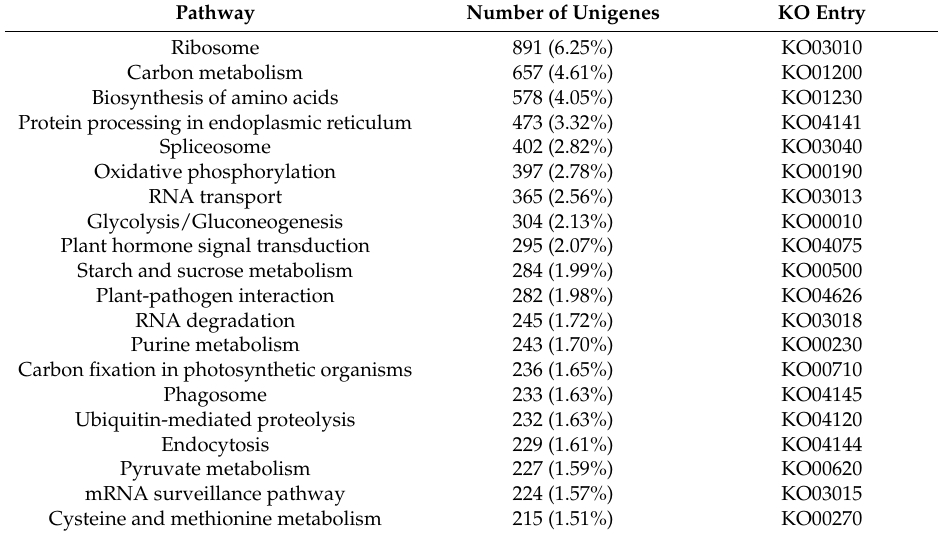
Table 4. The 20 most-represented KEGG pathways (KO, KEGG Orthology).